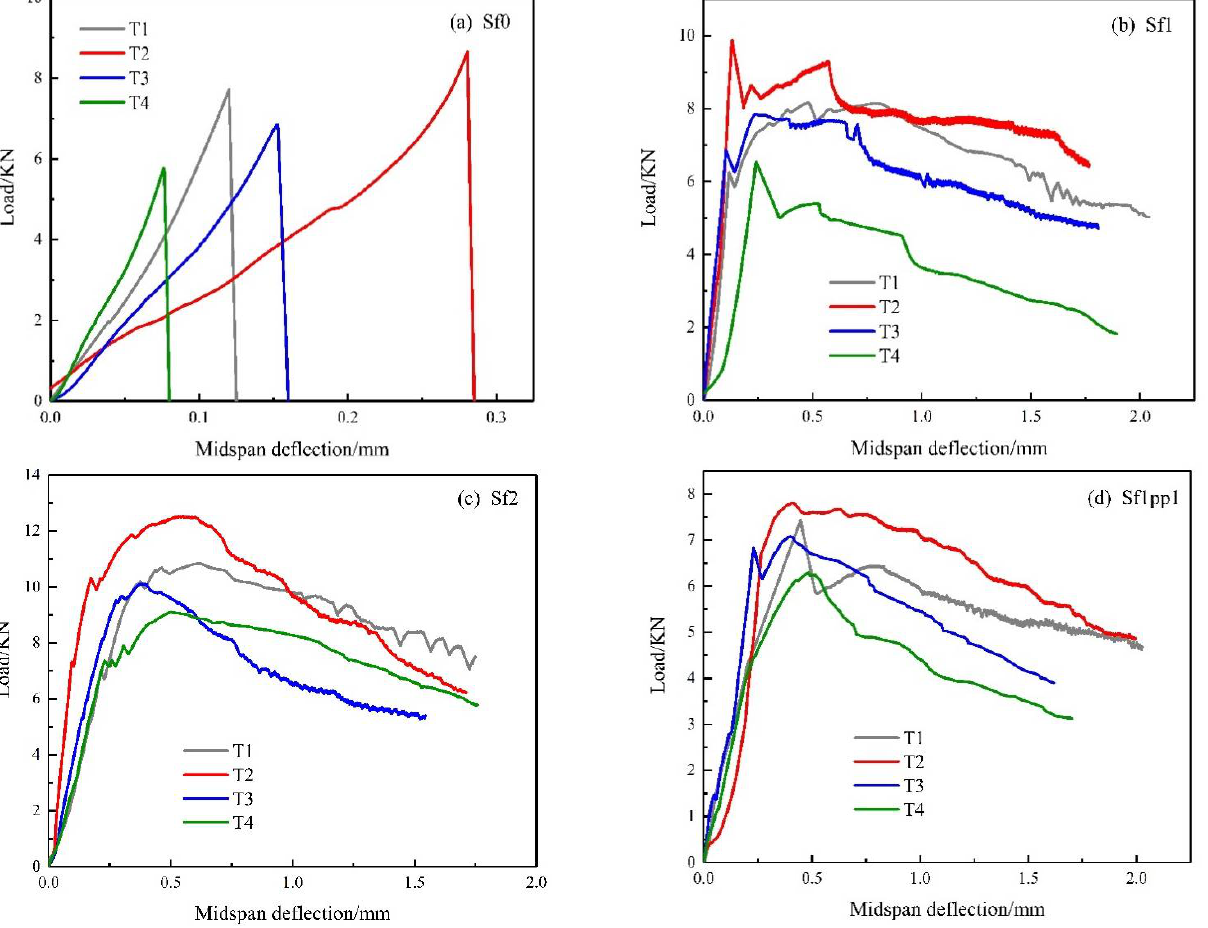
Figure 7. Load-deflection curves of each repaired system at different temperatures: ( a ) Sf0; ( b ) Sf1;( c ) Sf2; ( d ) Sf1pp1.